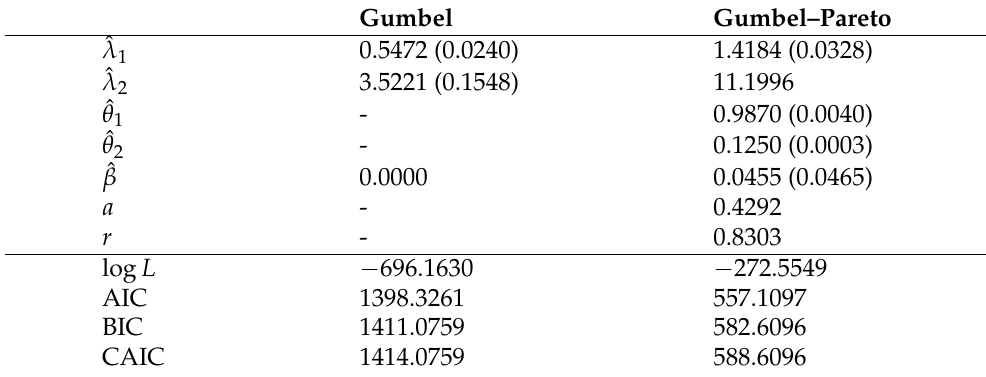
Table 4. MLE of bivariate distributions with standard errors in parentheses.